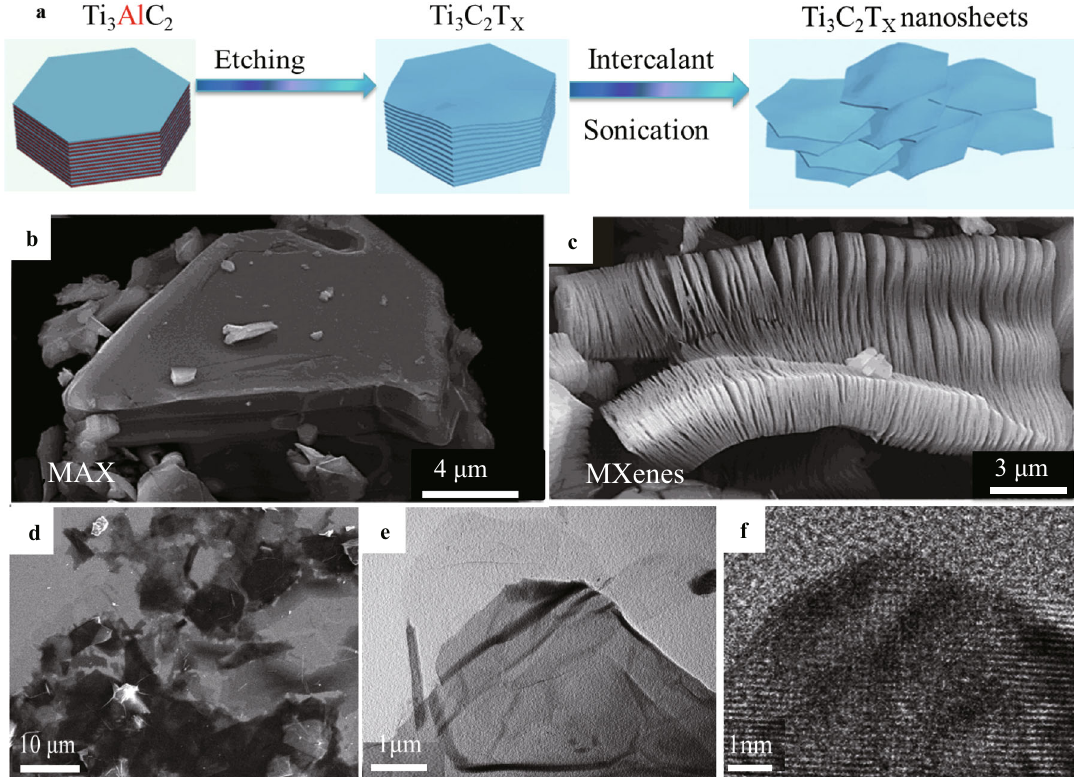
Fig. 2 The synthesis of MXenes from MAX phase by fl uoride etching. a Schematic diagram of MAX phase etching and MXenes formation. b SEM image of MAX phase before HF etching. c SEM image of multilayer Ti 3 C 2 T X after HF etching 44 . Copyright 2012, American Chemical Society. d – f SEM, TEM and high-resolution TEM images of monolayer Ti 3 C 2 T X nanosheet 45 . Copyright 2019, American Chemical Society.